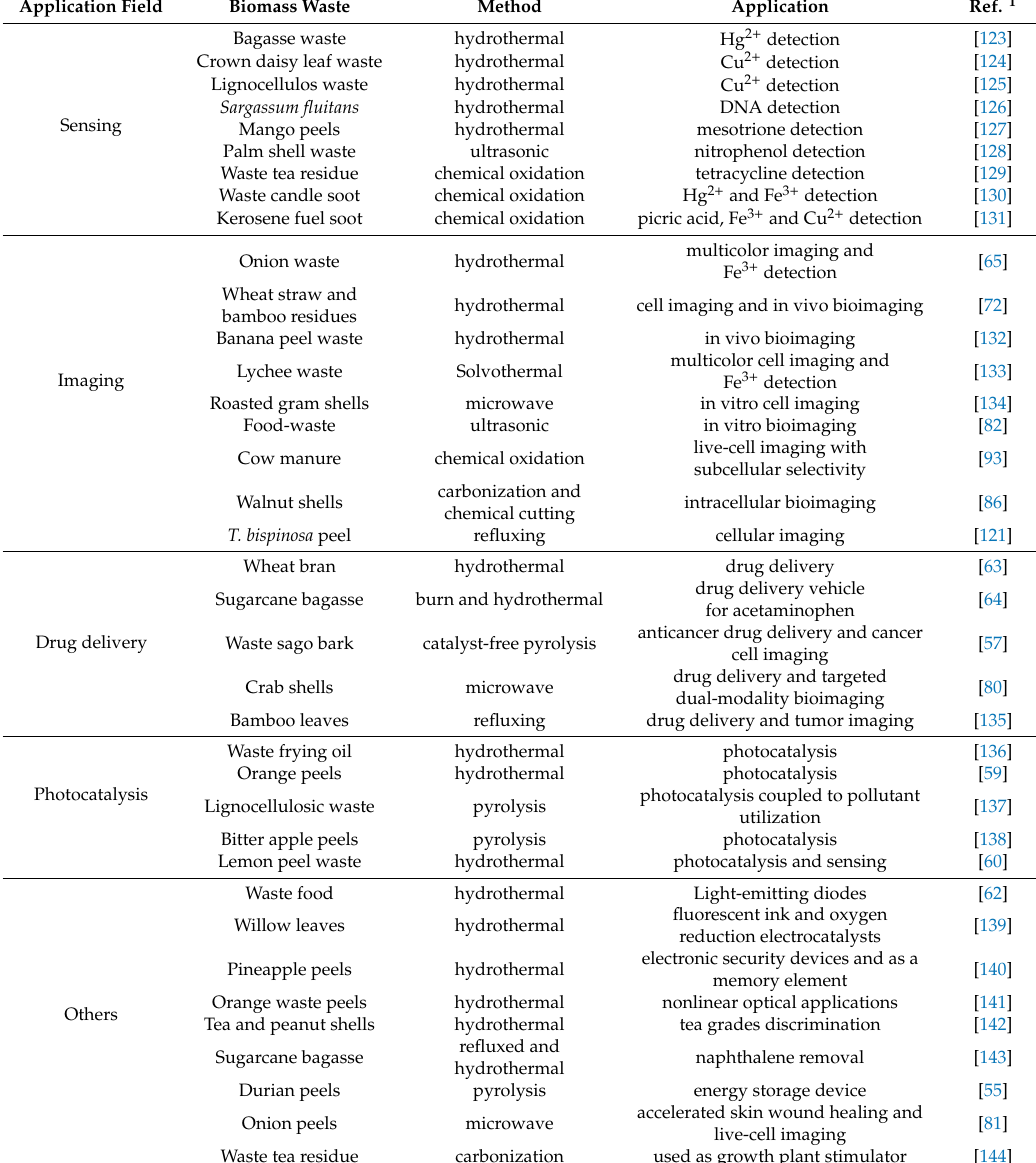
Table 2. An overview of many application fields of carbon dots obtained from biomass